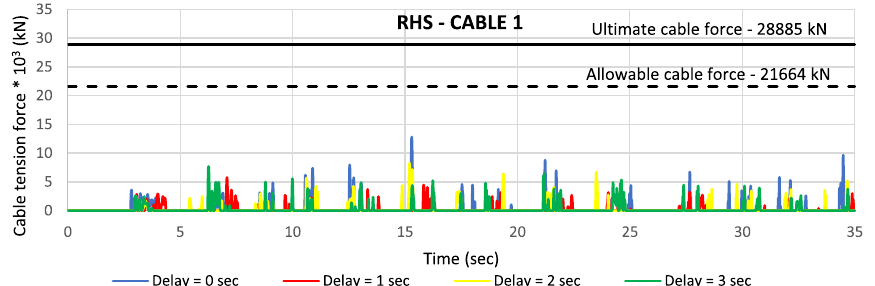
Fig. 17 Time history of forces in